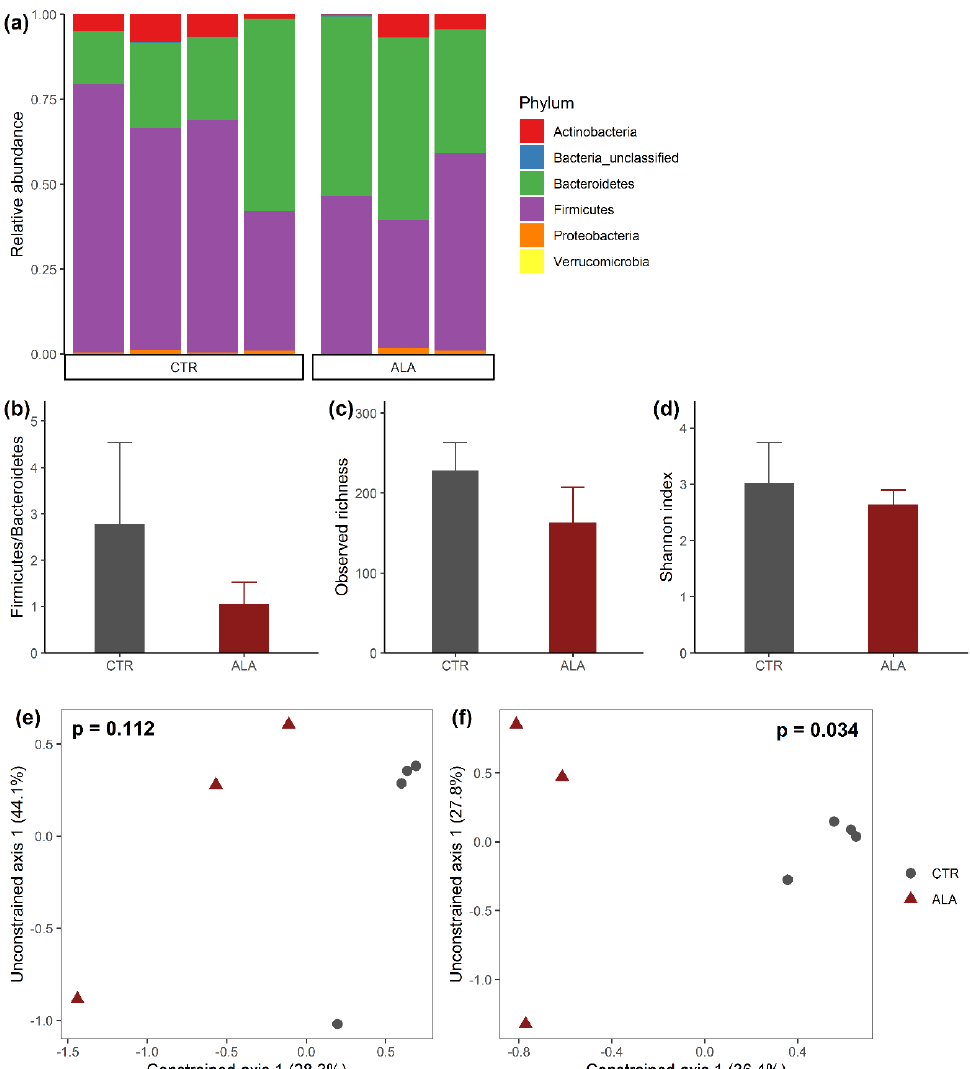
Figure 2. Microbial composition of the small intestine. ( a ) Bar plots show the relative abundance of bacterial phyla of individual animals in the control chow (CTR) or α -linolenic acid-rich diet group (ALA). ( b ) Firmicutes / Bacteroidetes ratio of CTR compared to ALA animals. α -diversity was investigated by estimating ( c ) the observed richness or ( d ) the Shannon index. Bar plots show mean + standard deviation for each measure per group. β-diversity was visualized using Canonical analysis of principle coordinates (CAP) based on ( e ) the Bray–Curtis dissimilarity or ( f ) binary Jaccard distance. P-values for the constrained axis from CAP were obtained using permutational analysis of variance (PERMANOVA) with 999 permutations. Since the treatment variable has only two levels (CTR or ALA), CAP produced only one constrained multivariate dimension. The percentage of the total inertia captured by each multivariate dimension is shown in brackets on the plots.